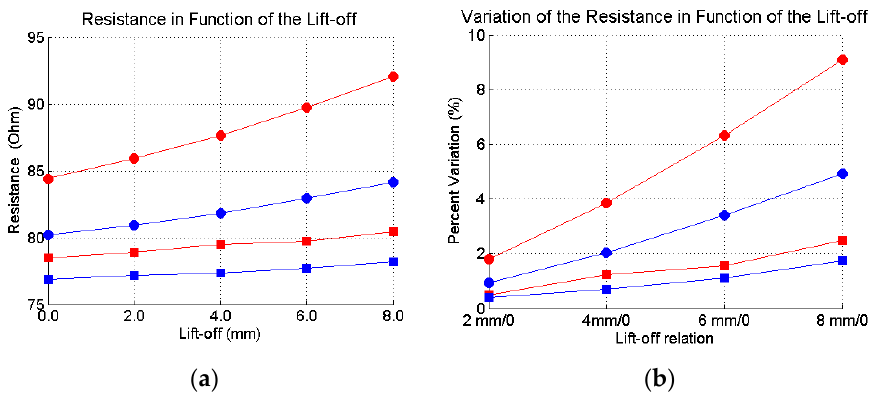
Figure 18. Lift-off effects on the resistance values. ( a ) absolute values; ( b ) Percent variation.